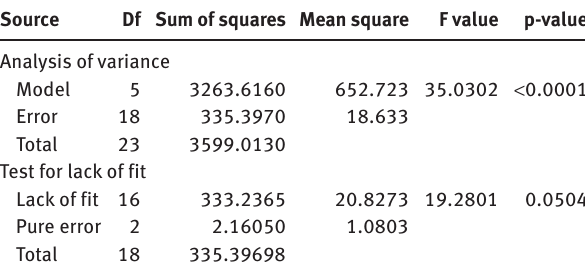
Table 3: Analysis of variance and test for lack of fit for the regression model.